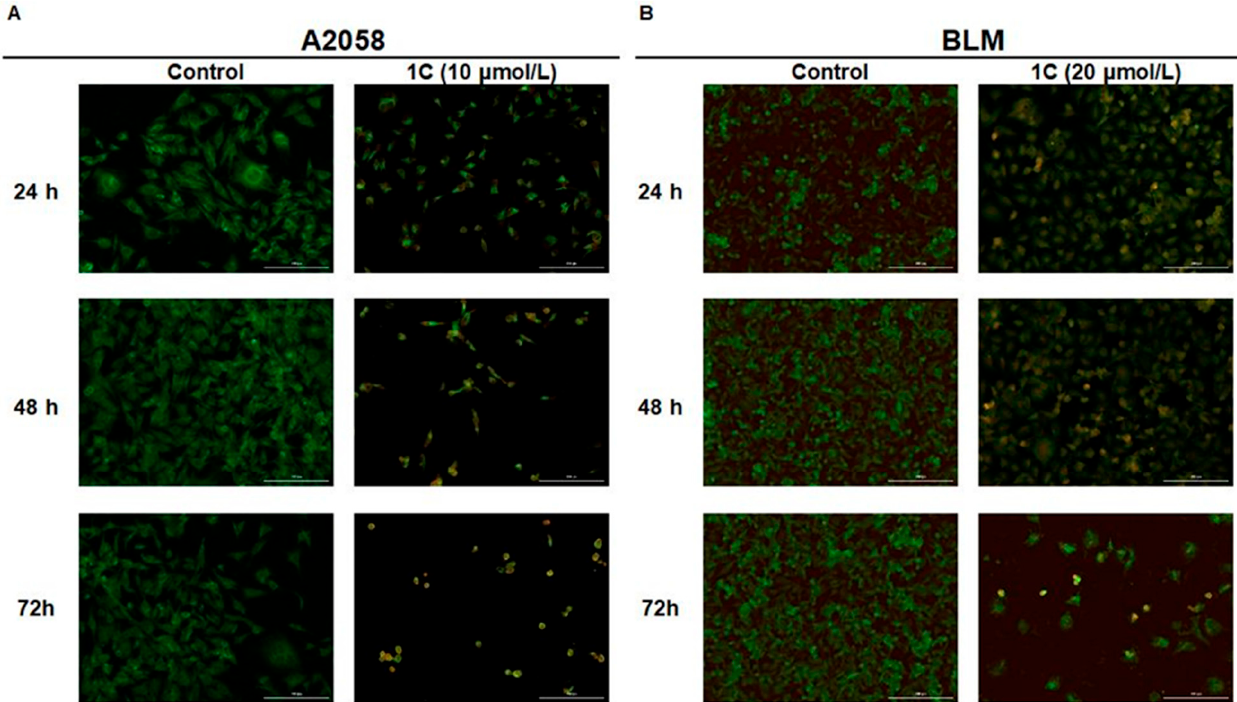
Figure 2. Fluorescence microscopy detection of apoptosis using AO/PI staining in A2058 ( A ) and BLM ( B ) melanoma cells after treatment with chalcone 1C at a concentration of 10 μ mol/L (A2058) and 20 μ mol/L (BLM) for 24, 48 and 72 h. Green = living cells, yellow = early apoptotic cells, orange = late apoptotic cells, red = dead/necrotic cells. A representative figure of three independent experiments is presented. Magnification is 100 × . Table 3. Cell cycle analysis of A2058 and BLM melanoma cells after treatment with chalcone 1C for 24, 48 and 72 h at a concentration of 10 µ mol/L (A2058) and 20 µ mol/L (BLM). A2058